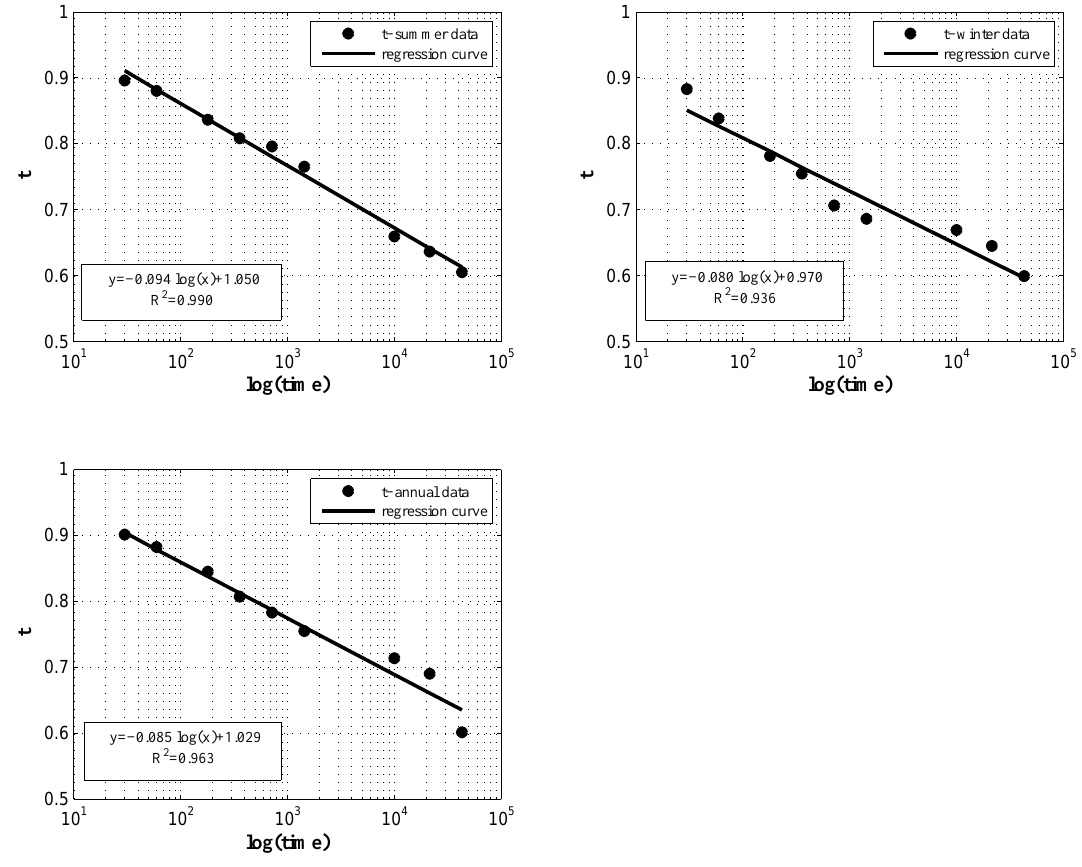
Fig. 5. Simple linear regression curve for maximum non-redundant information curve for summer and winter seasons (above) and annual data (below) on a semi-log scale. The equation and the coefficient of determination ( R 2 ) of each regression curve are given in the box below each